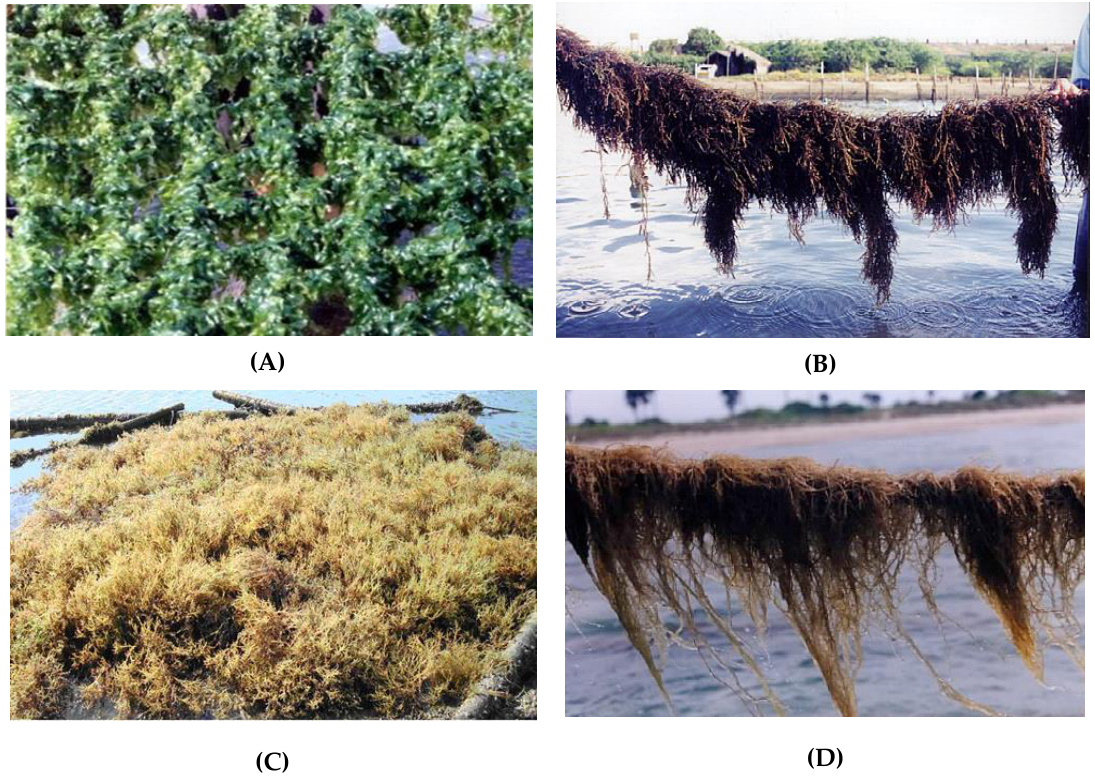
Figure 4. Cultivation of seaweeds. ( A ) Cultivation of Ulva on net. (Photo credit: R.M. Oza) ( B ) Cultivation of Hydropuntia edulis by long line rope method. (Photo credit: M. Ganesan) ( C ) Cultivation of Hydropuntia edulis by raft method. (Photo credit: M. Ganesan) ( D ) Cultivation of Hypnea by long line rope method. (Photo credit: M. Ganesan). Table 3. Economical important seaweeds and their cultivation in India.